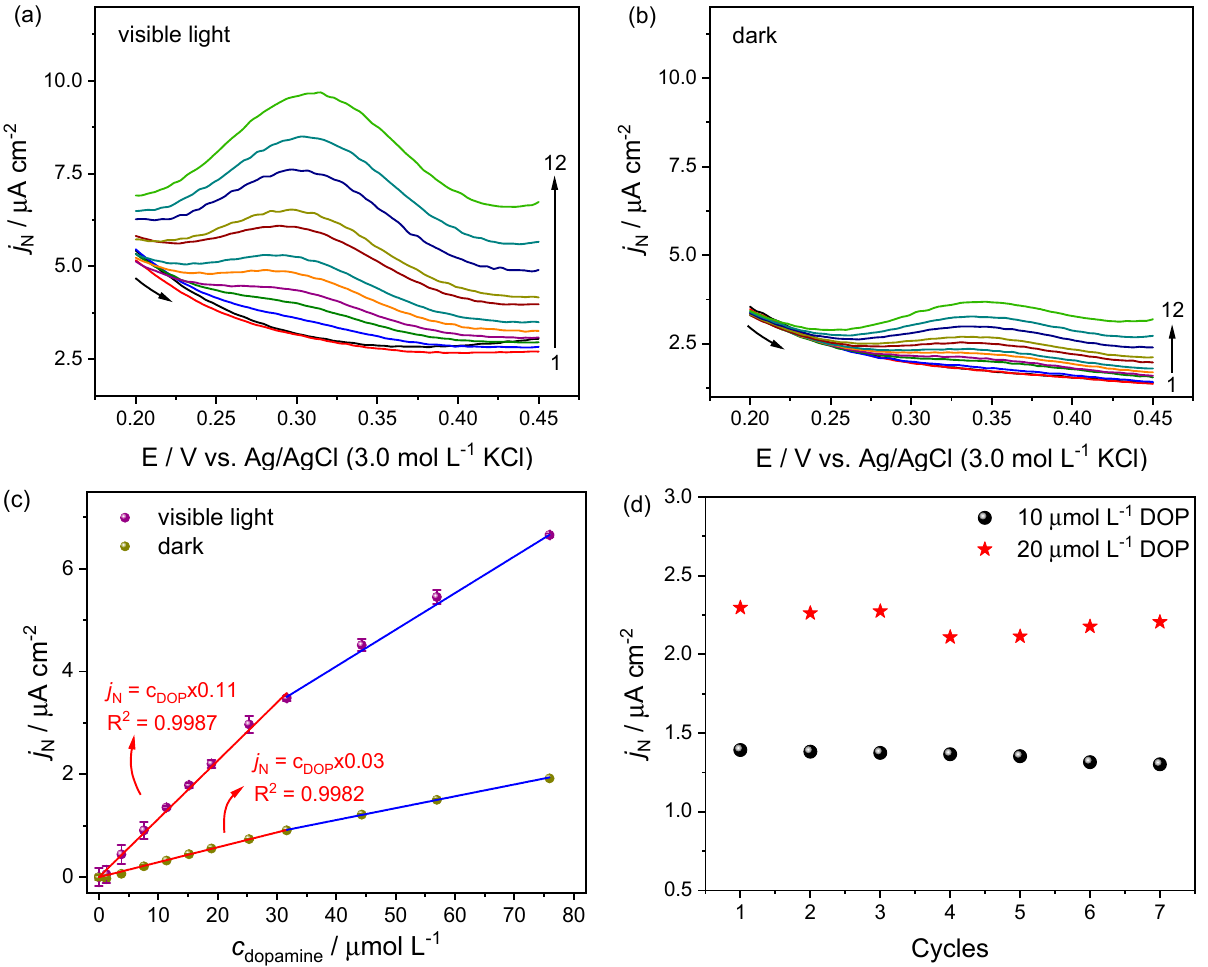
Figure 4. Differential pulse voltammograms obtained for dopamine in different concentrations (0, 1.27, 3.80, 7.59, 11.39, 15.19, 18.98, 25.31, 31.64, 44.29, 56.95, and 75.93 μ mol L − 1 , points from 1 to 12) in ( a ) presence, and ( b ), absence of visible light (dark). Supporting electrolyte: 0.1 mol L − 1 Na 2 SO 4 ; linear range between 0.2 and +0.45 V (vs. Ag/AgCl). ( c ) Analytical curve obtained by linear adjustment. ( d ) Reproducibility test with 10 and 20 μ mol L − 1 dopamine concentration.